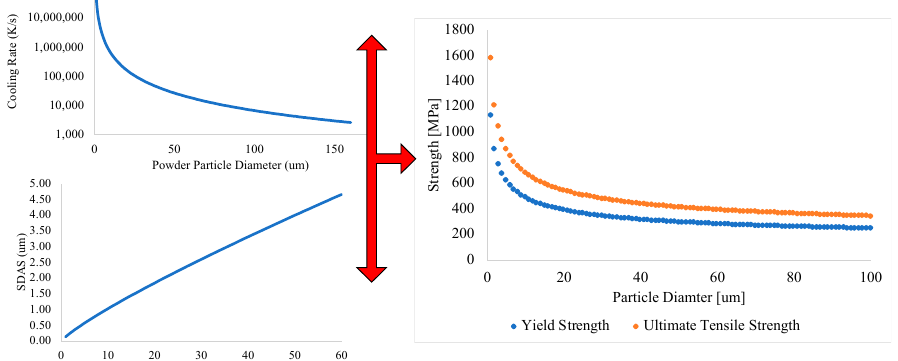
Figure 20. The upper left-hand plot presents the cooling rate as a function of powder particle diameter. The secondary dendrite arm spacing (SDAS) is given as a function of particle diameter on the lower left-hand plot. Finally, the strength as a function of particle diameter is plotted for pure copper on the right-hand side. The cooling rate is able to discern the SDAS size as a function of particle diameter, such that the Hall–Petch relation can unveil the strength-particle behavior. The multiple red arrow tips were imposed upon the figure to highlight the interplay between the y -axis variables. Metals 2020 , 10 , x FOR PEER REVIEW